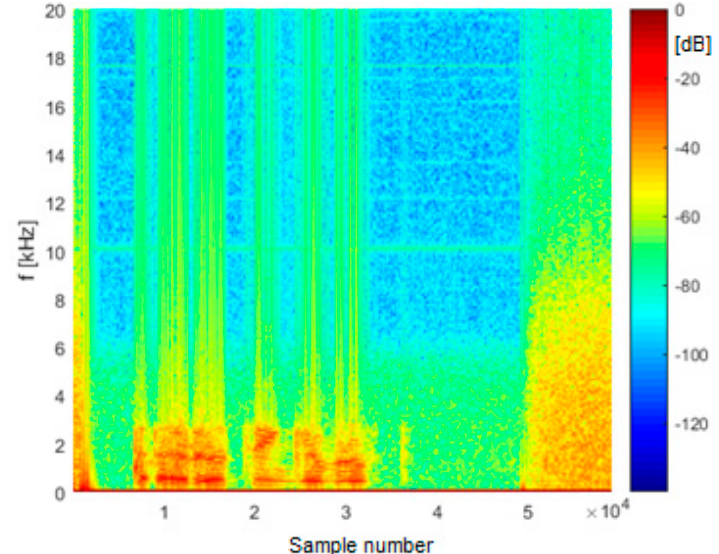
Figure 12. An example spectrogram of an audio file.